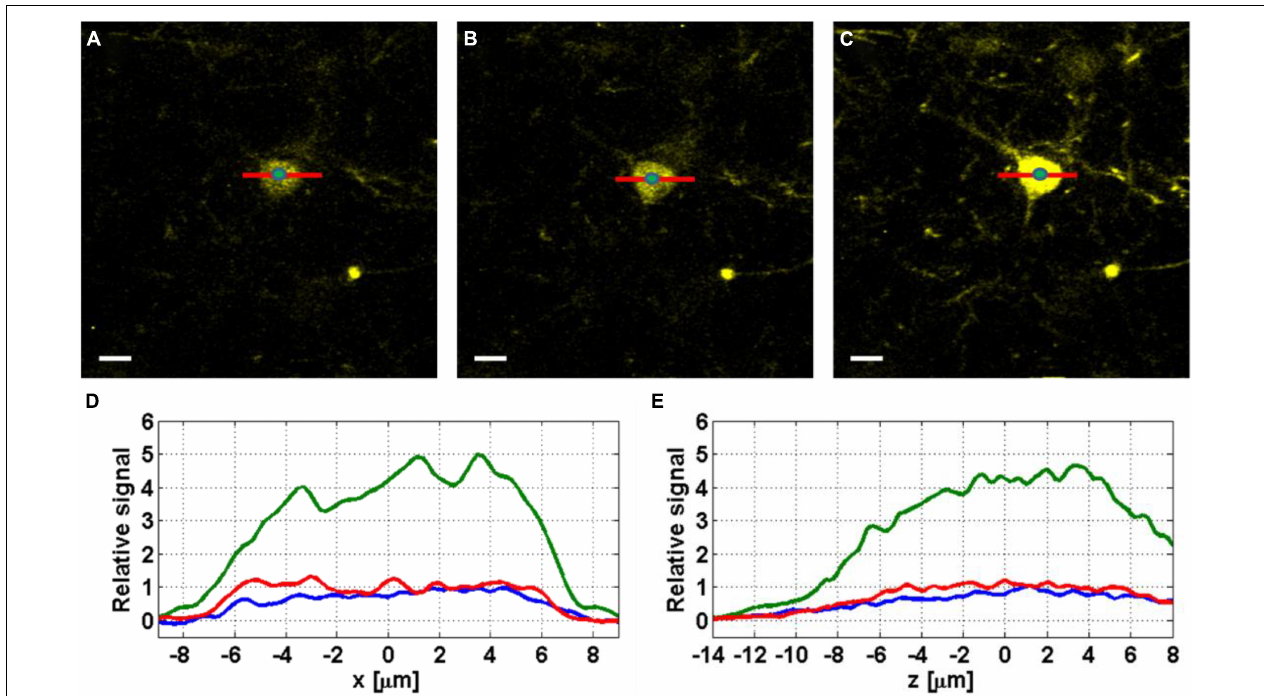
FIGURE 3 | Images of YFP labeled neurons at 800 µ m below the surface of the mouse brain, before correction (A) , with shallow correction (B) , and full correction at 800 µ m depth (C) . Scale bar, 10 µ m. The green dots at the center of the neurons indicate the locations where the axial profiles in panel (E) are evaluated. (D) Lateral ( x ) line profiles were taken without correction (blue), with shallow correction (red), and with full correction (green). (E) Axial ( z ) line profiles taken from z -stacks with 0.2 µ m step around the imaging plane, without correction (blue), with shallow correction (red), and with full correction (green).